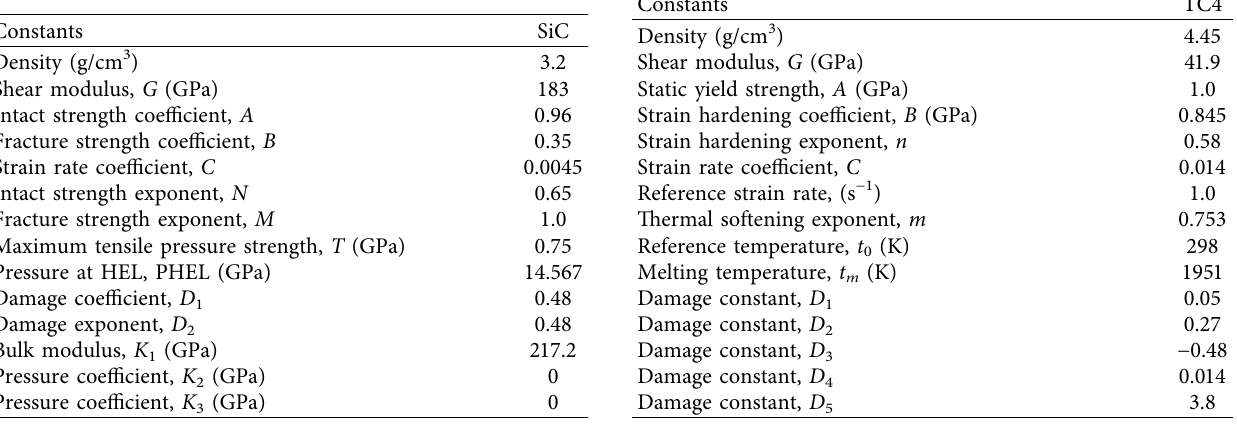
Table 1: ∗ MAT_JOHNSON_HOLMQUIST_CERAMICS [22] constants for SiC.